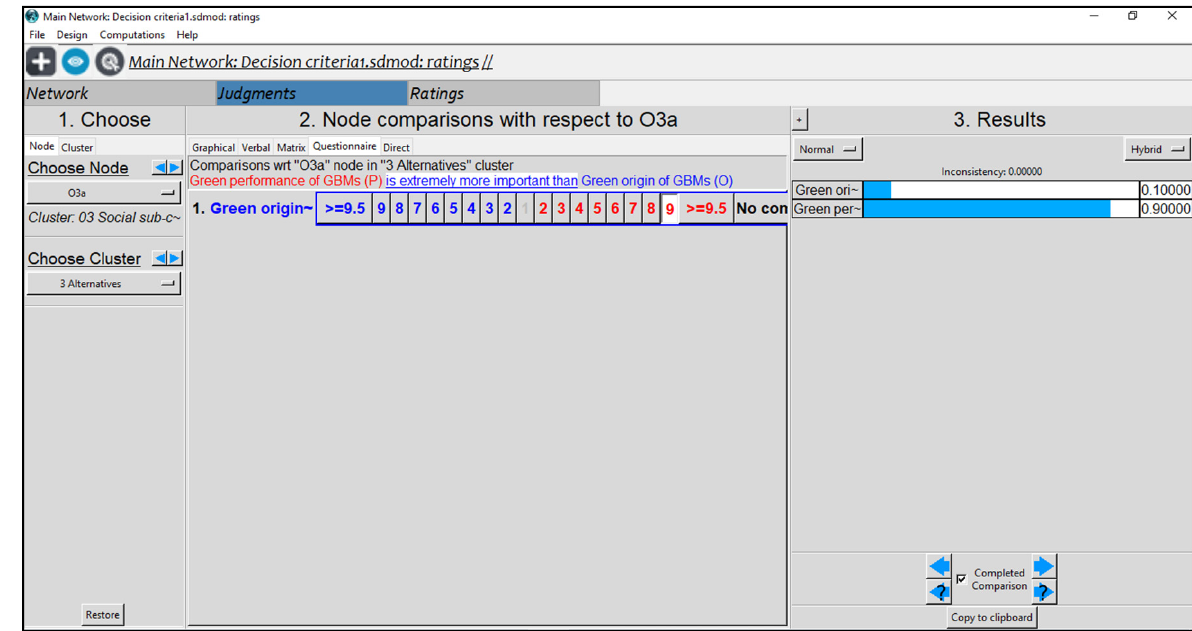
Figure A3. A sample of local preferences for each alternative with respect to sub-criteria.